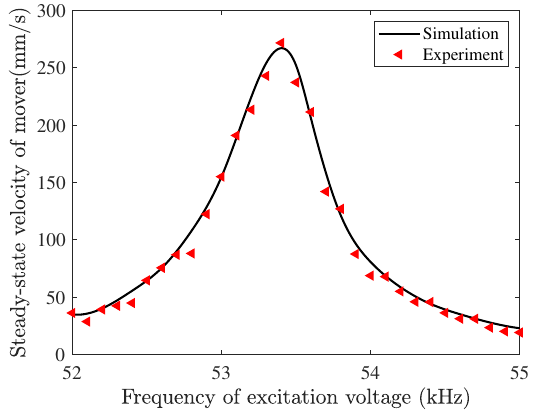
Figure 30. Velocity of the mover versus the frequency of the excitation voltage.